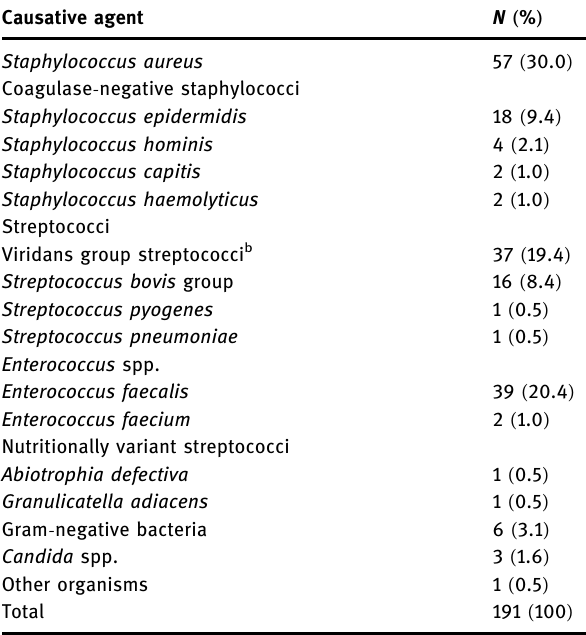
Table 2: Causative agents of CPIE